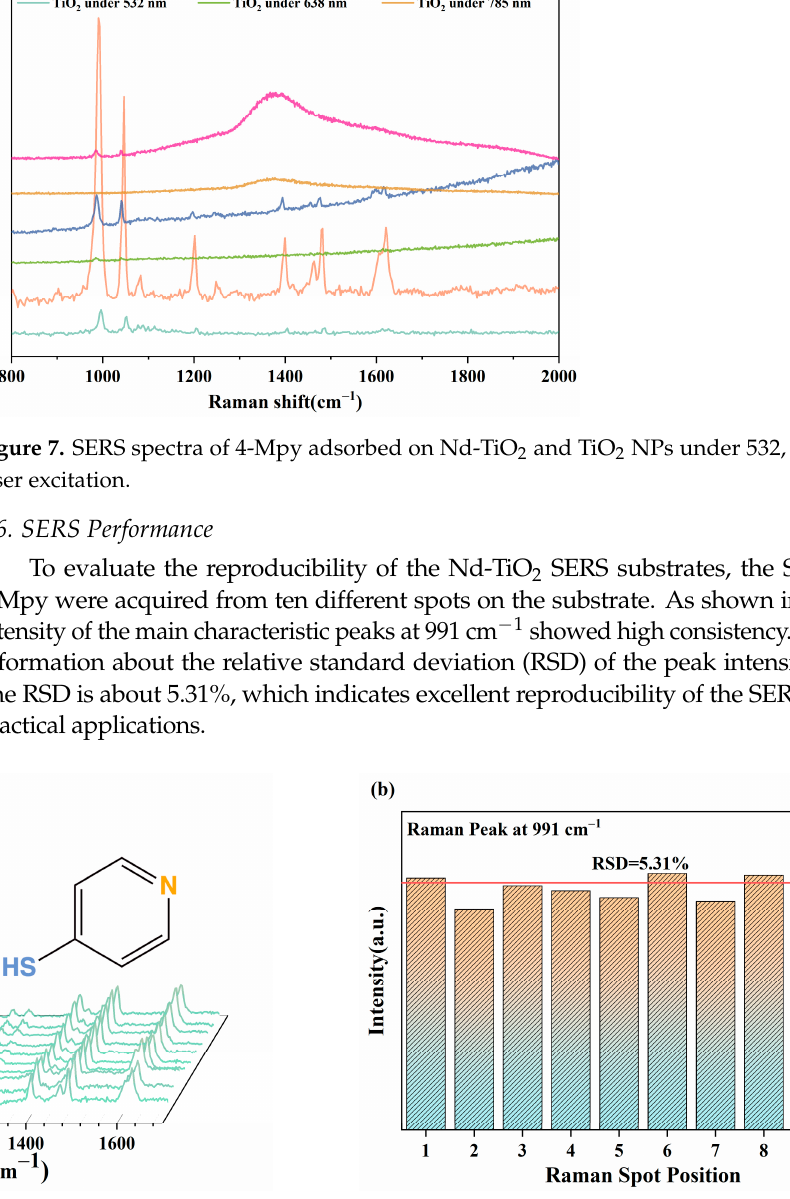
Figure 9. ( a ) SERS spectra of the 4-MPy on 2%Nd-TiO 2 NPs substrates with different concentrations from 10 − 2 to 10 − 7 M; ( b ) Raman intensity at 991 cm − 1 versus the concentration of 4-Mpy ranging from 10 − 2 to 10 − 7 M. To quantitatively investigate the enhancement ability, the enhancement factor (EF) for as-prepared SERS substrate can be calculated by the following equation: 𝐸𝐹 = (𝐼 (cid:3020)(cid:3006)(cid:3019)(cid:3020) 𝐼 (cid:3003)(cid:3048)(cid:3039)(cid:3038) )(𝑁 (cid:3003)(cid:3048)(cid:3039)(cid:3038) 𝑁 (cid:3020)(cid:3006)(cid:3019)(cid:3020) ) where I SERS and I Bulk are the Raman intensities of 4-Mpy in the SERS spectra and standard Raman spectra and N SERS and N Raman present the numbers of 4-Mpy molecules adsorbed on the SERS substrate and in the bulk condition, respectively. The ratio of intensities ( I SERS / I Bulk ) can be obtained by 4-Mpy in the SERS spectra and standard Raman spectra (Figure S2), and is 37.57. The N Bulk and N SERS are 7.83 × 10 10 and 7.79 × 10 7 , respectively (the detailed calculation process is shown in the Supporting Infor-